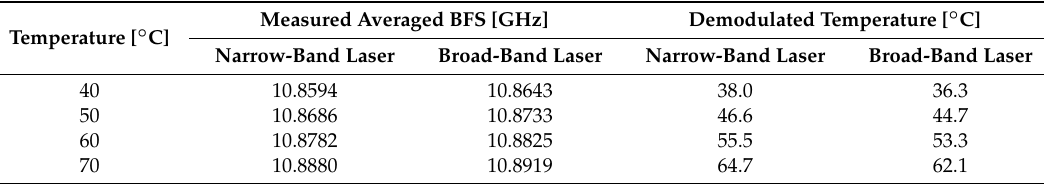
Table 2. Measured averaged BFS and demodulated temperature of the heated fiber at different thermostatic water bath